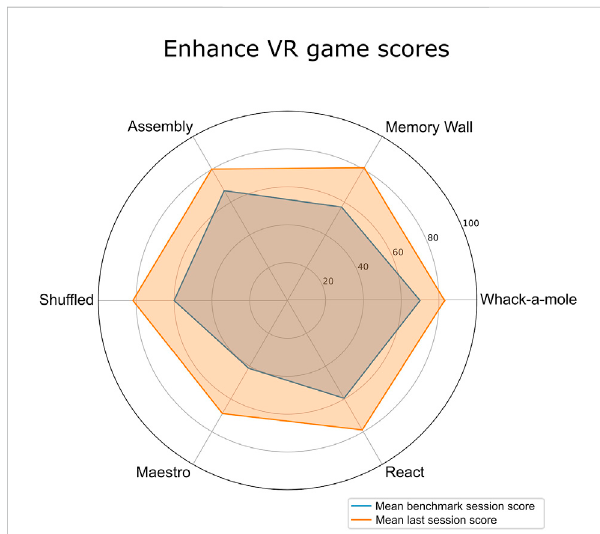
FIGURE 3 Mean benchmark session and last session score for each game. Spider chart depicting the mean of the scores of all participants obtained in the benchmark session (in blue), which assesses the baseline performance in the fi rst session of each game, and the mean score obtained in the last session played of each game (in orange). The graphs show that overall the scores of the participants increased, suggesting better performance in all games. The scores are shown as the Enhance VR score of 0 to